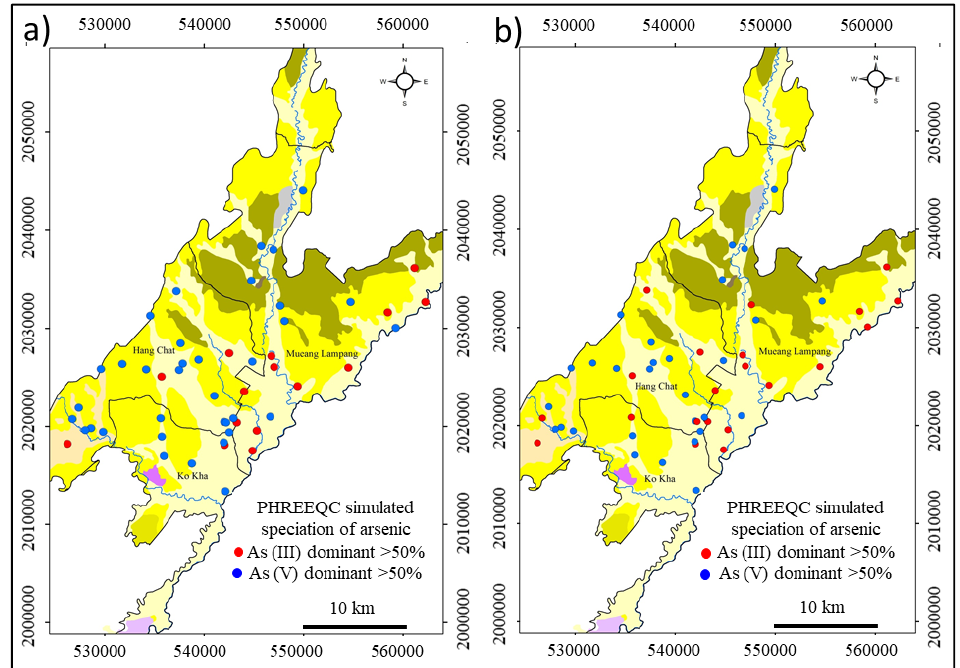
Figure 10. Distribution of As(III) and As(V) in deep groundwater in the ( a ) wet and ( b ) dry